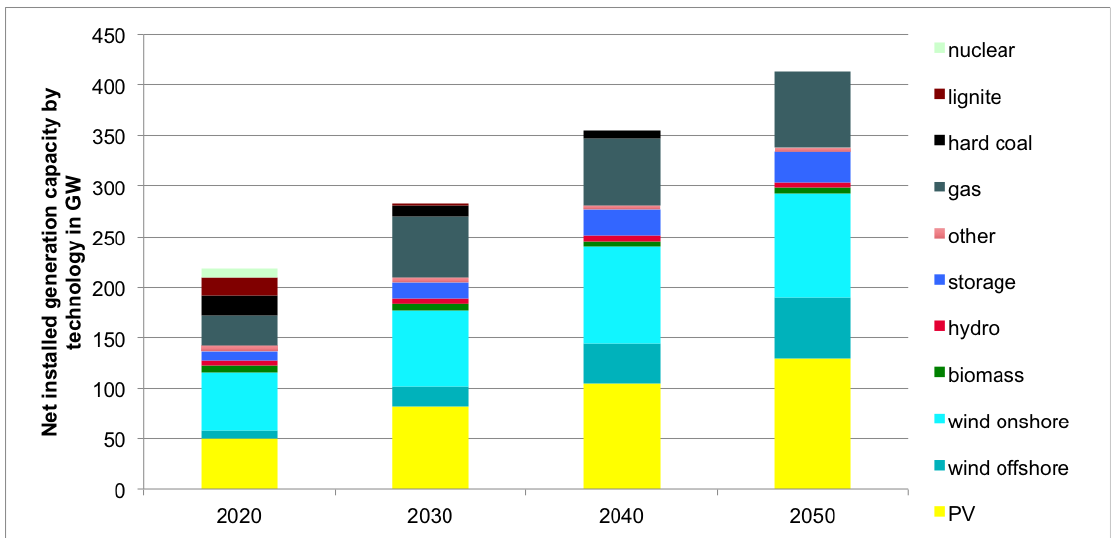
Figure 2. Net installed generation capacity by technology according to [13].